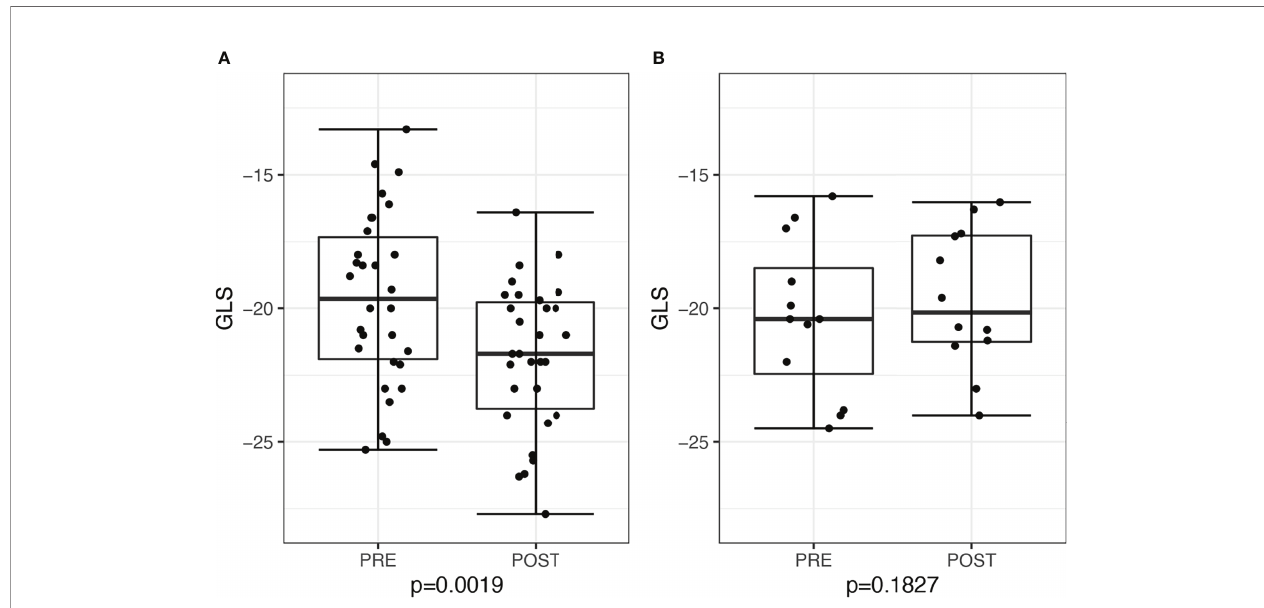
FIGURE 4 | Global longitudinal score (GLS) in patients before and after treatment for primary aldosteronism strati fi ed by post-treatment plasma renin activity (PRA). (A) Patients with post-treatment PRA >1 ng/ml/h (n = 30) and (B) patients with post-treatment PRA ≤ 1 ng/ml/h (n =